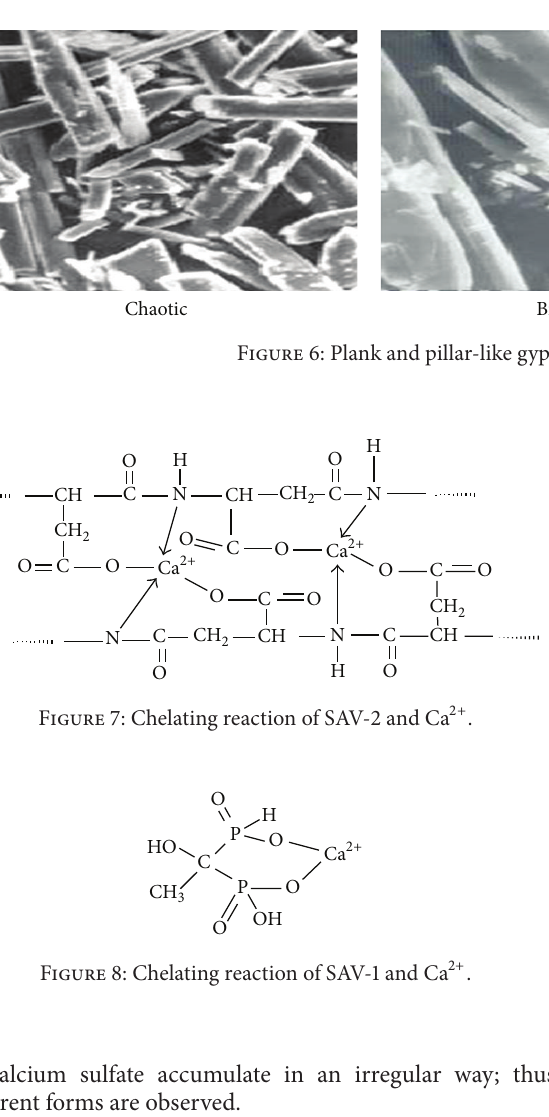
Figure 5: Plank and pillar-like gypsum crystal before SAV-1/SAV-2 treatment. ∗ Annotation: 200x, 700x, and 1000x are the magnification under observation.